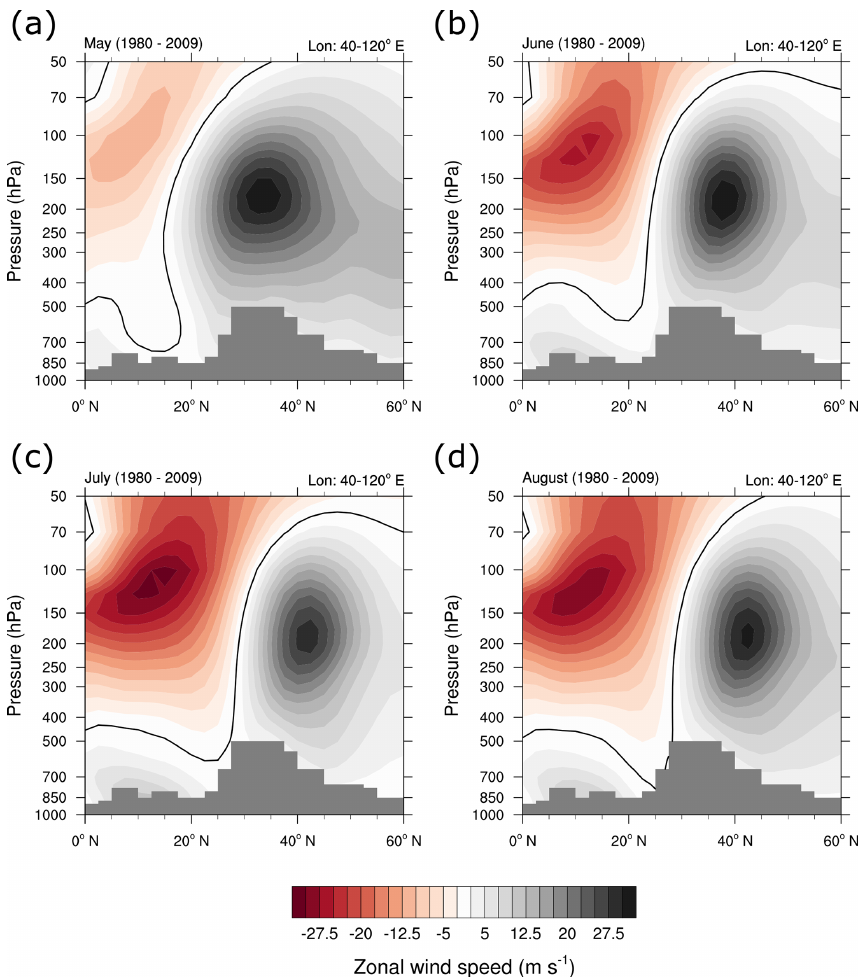
Figure 17. Zonal winds from ERA-Interim for (a) May to (d) August averaged over 1980 to 2009 and 40–120 ◦ E. Red (grey) colours indicate westward (eastward) winds, and black contours indicate the zero wind line. Grey shadings mark